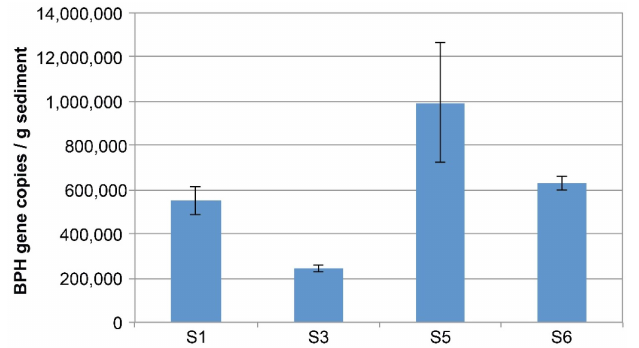
Figure 8. Quantification of bacterial biphenyl dioxygenase (BPH) genes in Guánica Bay sediments as determined by real-time PCR. The highest levels of BPH were detected in the coastal sample